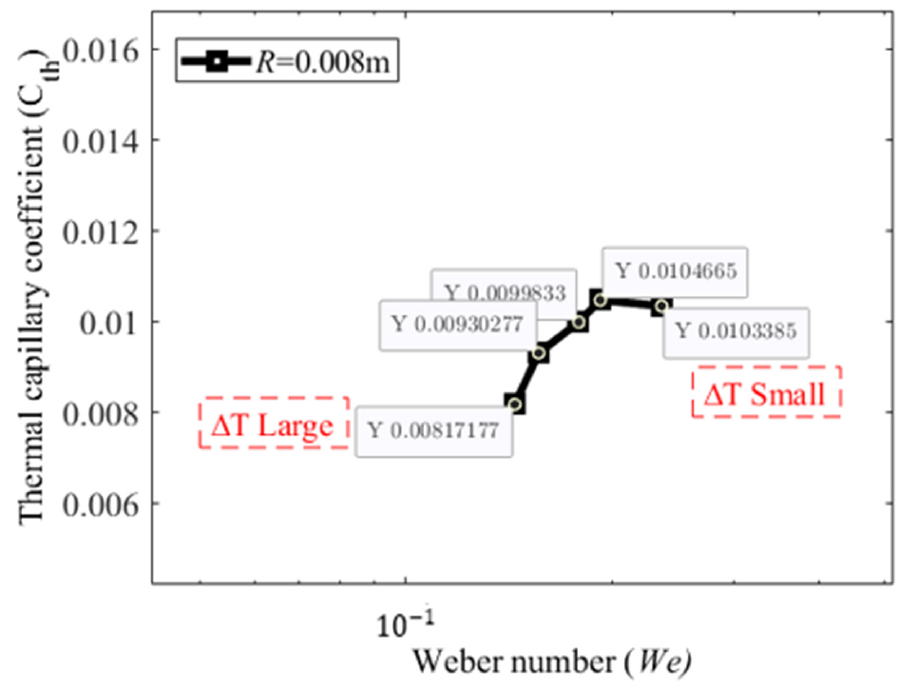
Figure 12. Thermo-capillary coefficient ( C Th ) vs. the Weber number ( We ) for R = 0.008 m.